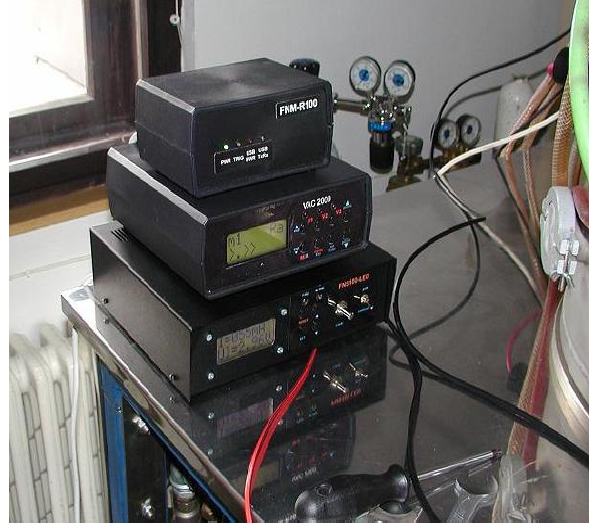
Fig. 7. A socket-outlet adaptor for RS485 FNM-R100 (up), a source for LED FNM-Z100 (down) and a vacuum measurement and controller VAC 2000 (in the middle) 9